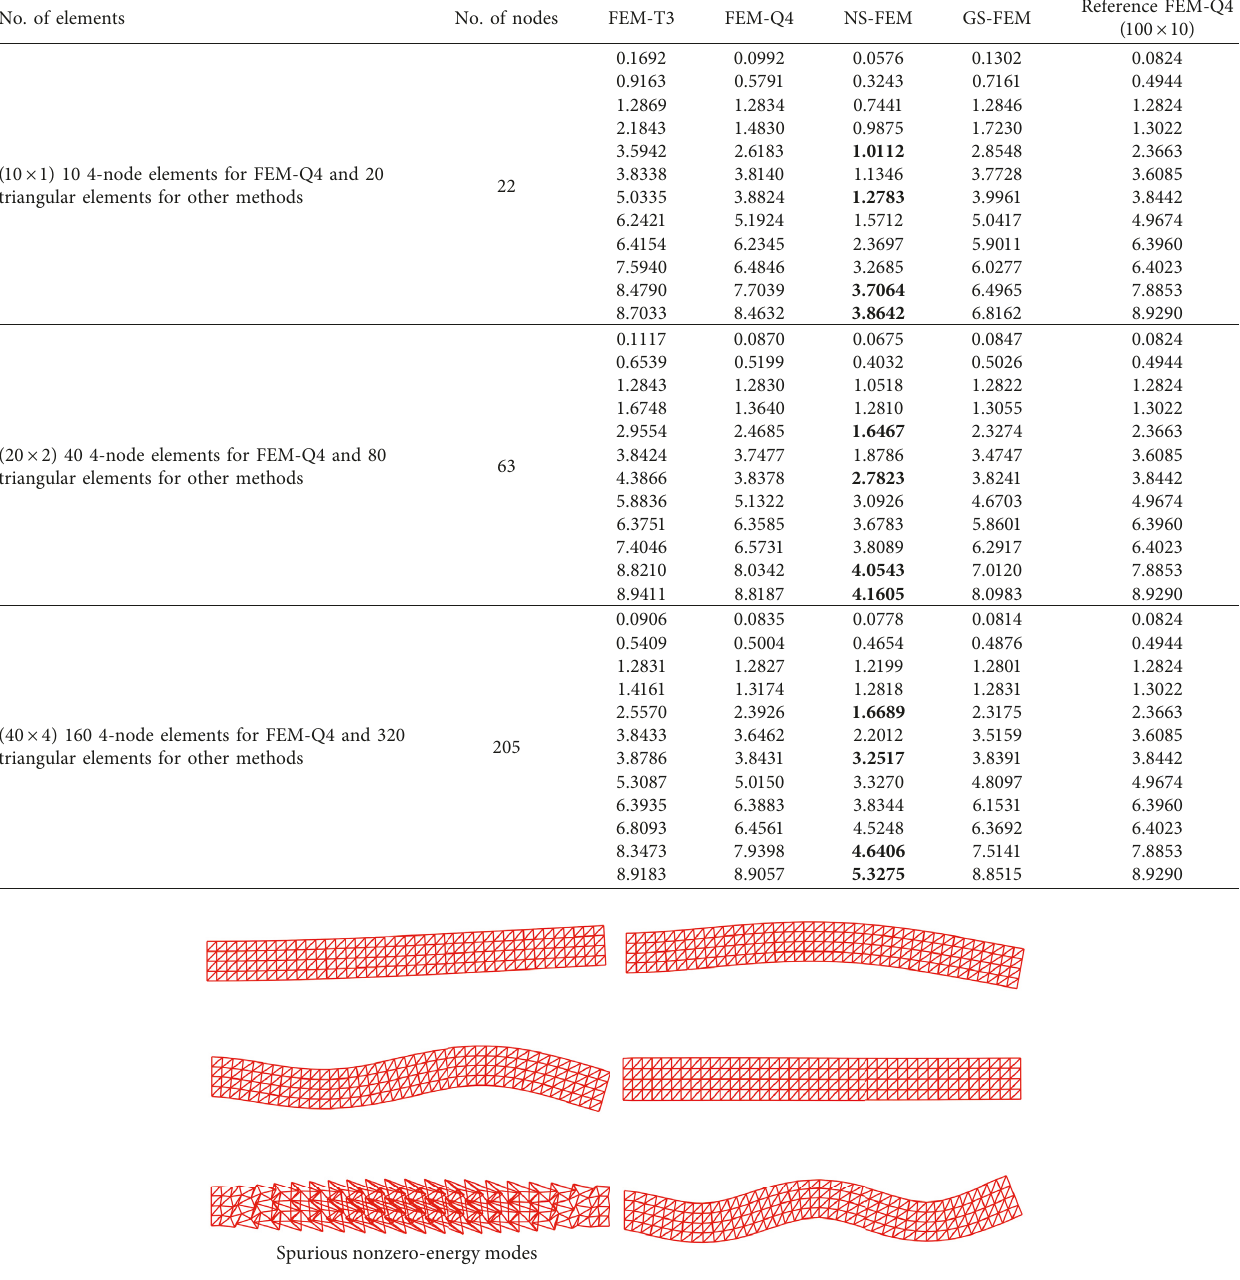
Table 2: First 12 natural frequencies (104 Hz) of a cantilever beam.